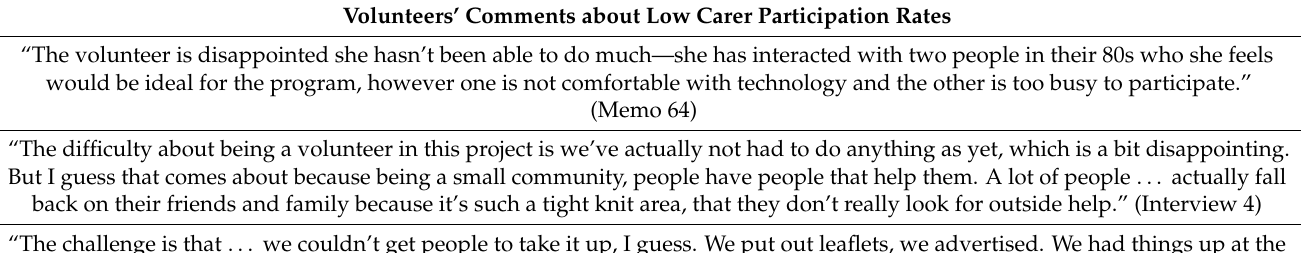
Table 2. Challenge caused by low numbers of carer